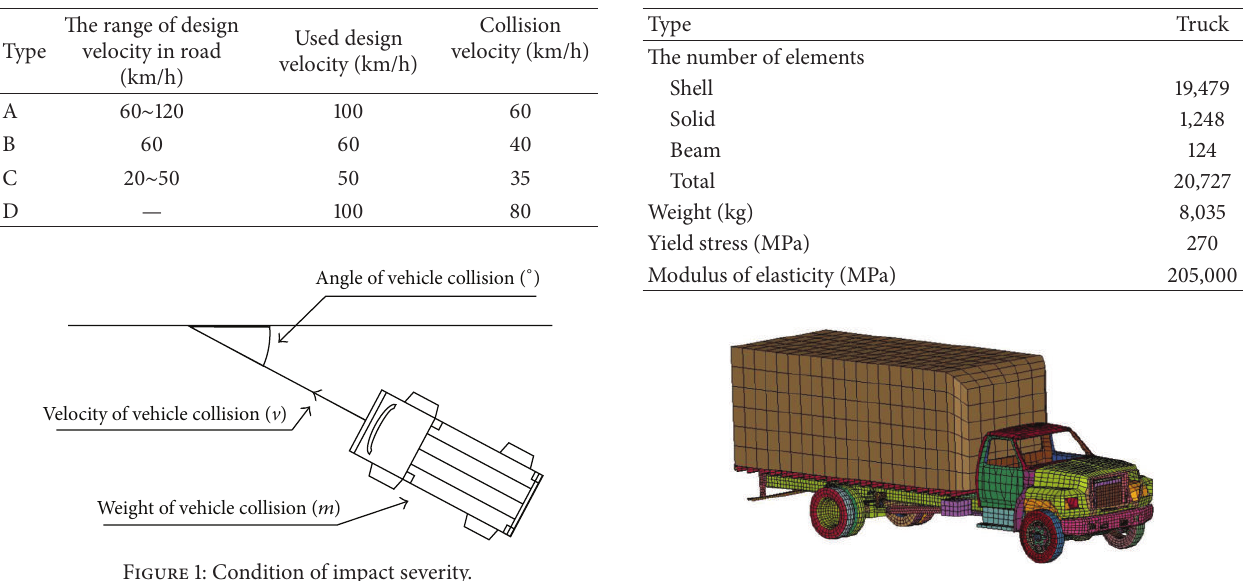
Figure 2: Three-dimensional model of Ford single-unit